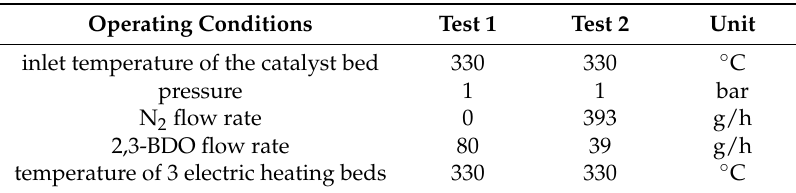
Table 2. Reactor operating